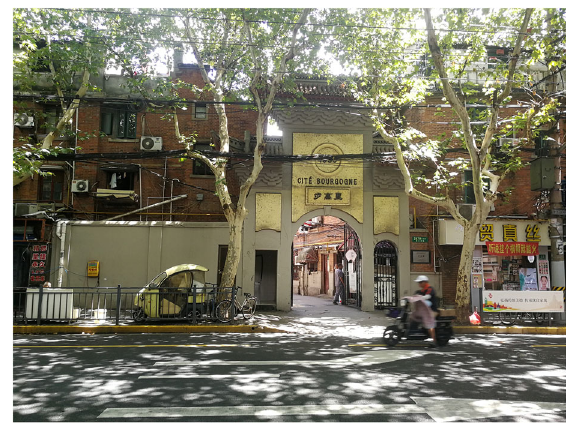
Fig. 1 Facing the South Shaanxi Road, the French name ‘ Cité Bourgogne ’ and the Chinese name ‘ 步 高 里 ’ were carved on the archway of the main entrance (Source: Kaiyi Zhu,